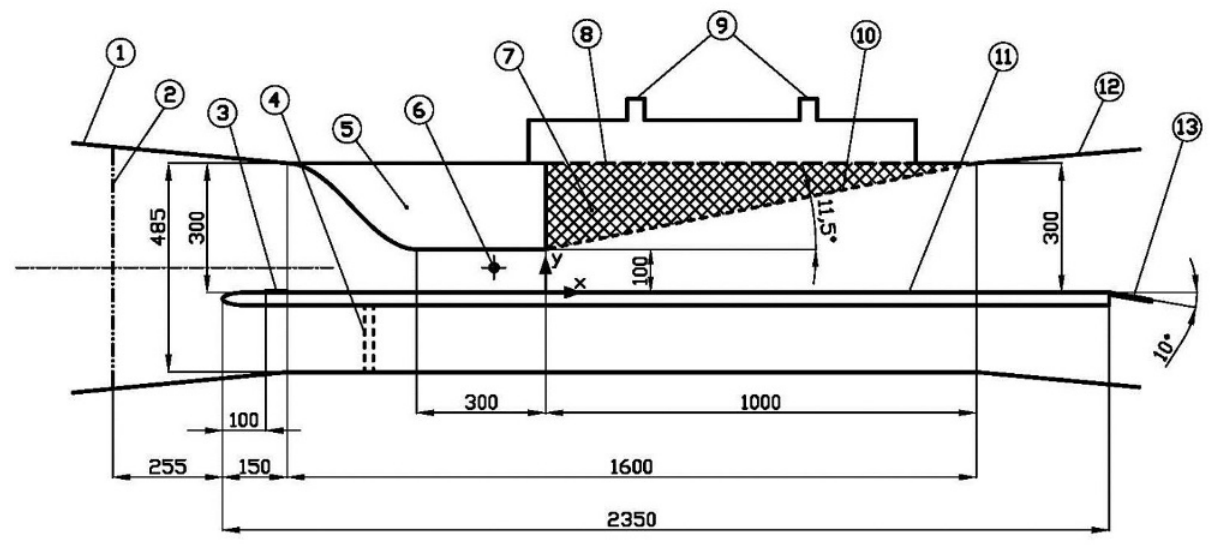
Fig. 1. Scheme of the experimental set up: 1. contraction, 2. turbulent generator, 3. sandpaper belt, 4. pressure drop generators, 5.displacement body, 6. Pitot-static tube, 7. porous material, 8. perforated wall, 9. suction, 10. woven screen plane diffuser, 11. smooth flat plate, 12. diffuser, 13. flap